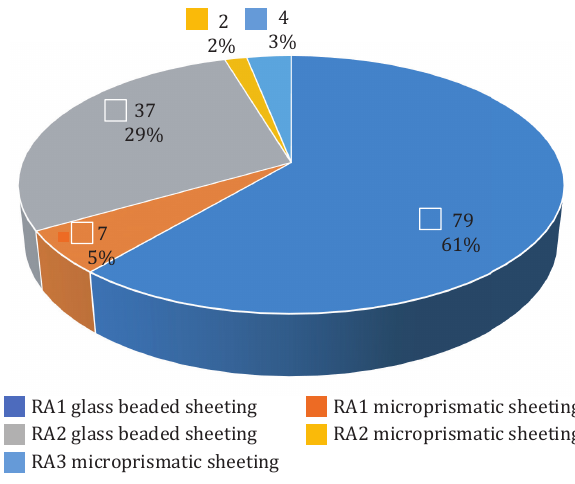
Figure 7. Pedestrian crossing signs by RA class and sheeting